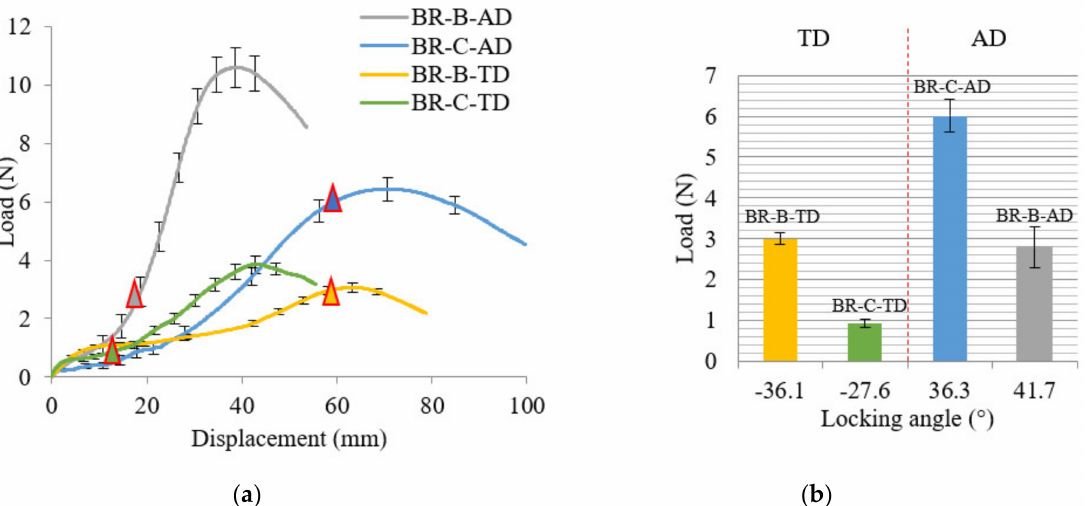
Figure 11. Influence of the braiding angle on thermal in-plane shear behavior: ( a ) global load versus displacement curves and ( b ) global load at locking